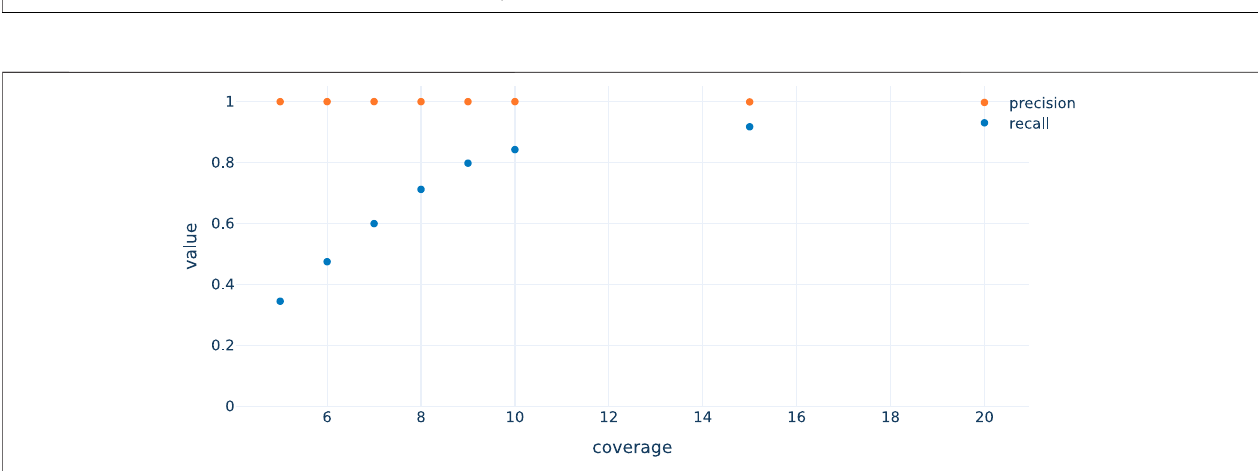
FIGURE 3 | Steps for detection of circular DNA fragments (0) Mapping of nanopore reads to a reference genome using minimap2. (1) Estimation of read depth for each genomic locus and identi fi cation of split reads. (2) Building of a directed graph, where each node is a genomic locus and edges indicate split reads, covered segments or deletions. After inserting nodes and edges, the graph is pruned by removing nodes that only have split read edges. (3) For each strongly connected component, generate circular event candidates by enumerating plausible circular paths; a circular path is only plausible if every other edge is a coverage edge or if its length is two and it has two coverage and split read edges. (4) Call circular event candidates with varlociraptor. Calls from varlociraptor are then annotated with additional information and translated to tsv-format for the fi nal report.